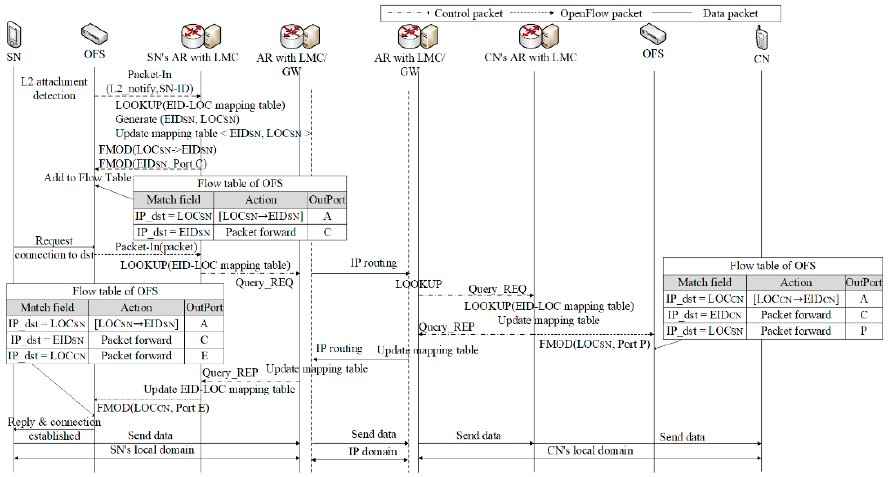
Figure 2. Registration and packet forwarding processes.